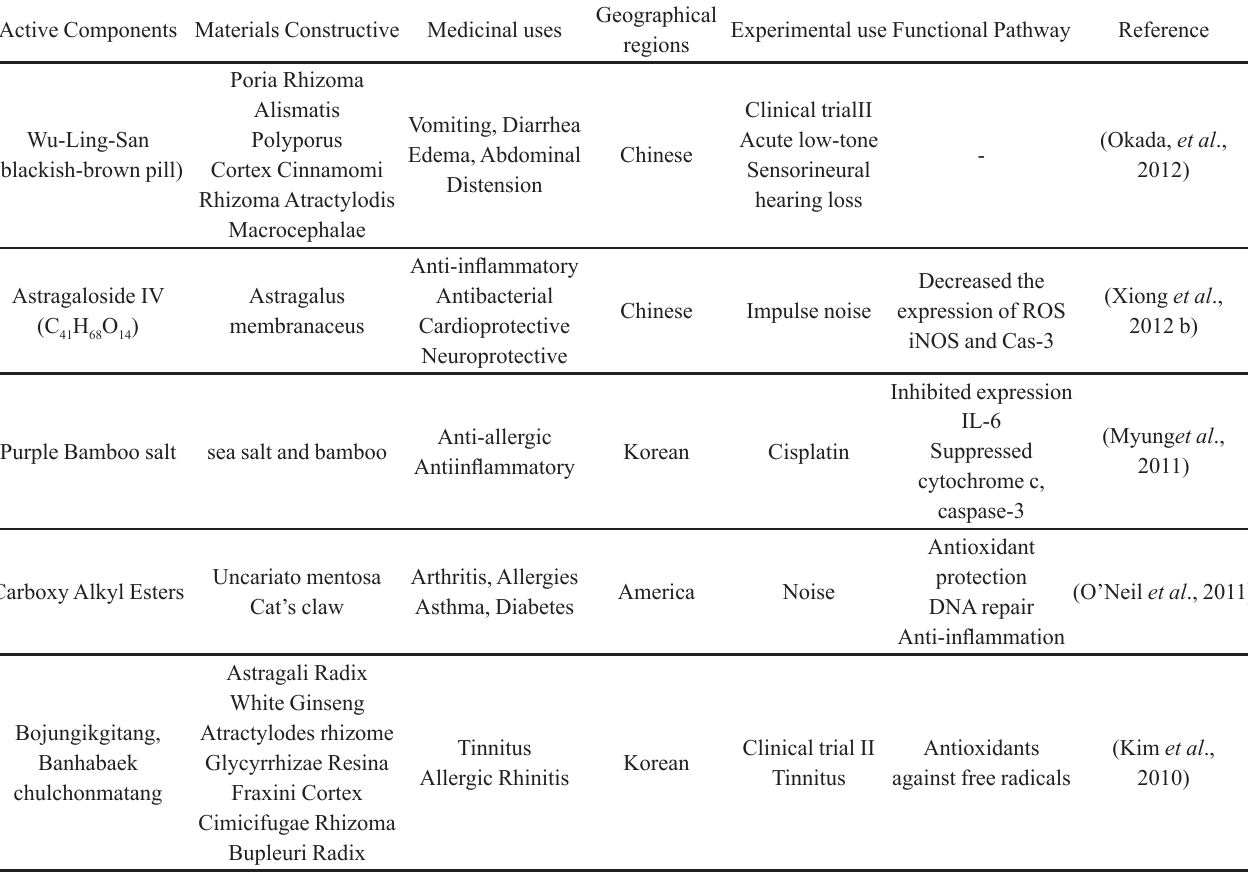
TABLE II - The list of Active Components ofmedicinal plants used to treat ototoxicity induced by gentamicin, cisplatine and noise in the